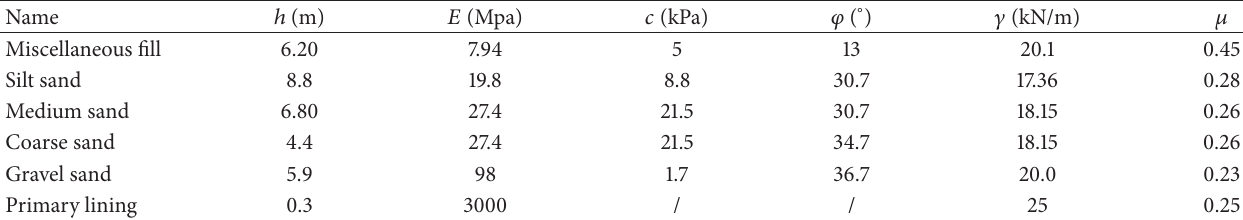
Table 1: Mechanical parameter of soil layer and supporting structure.